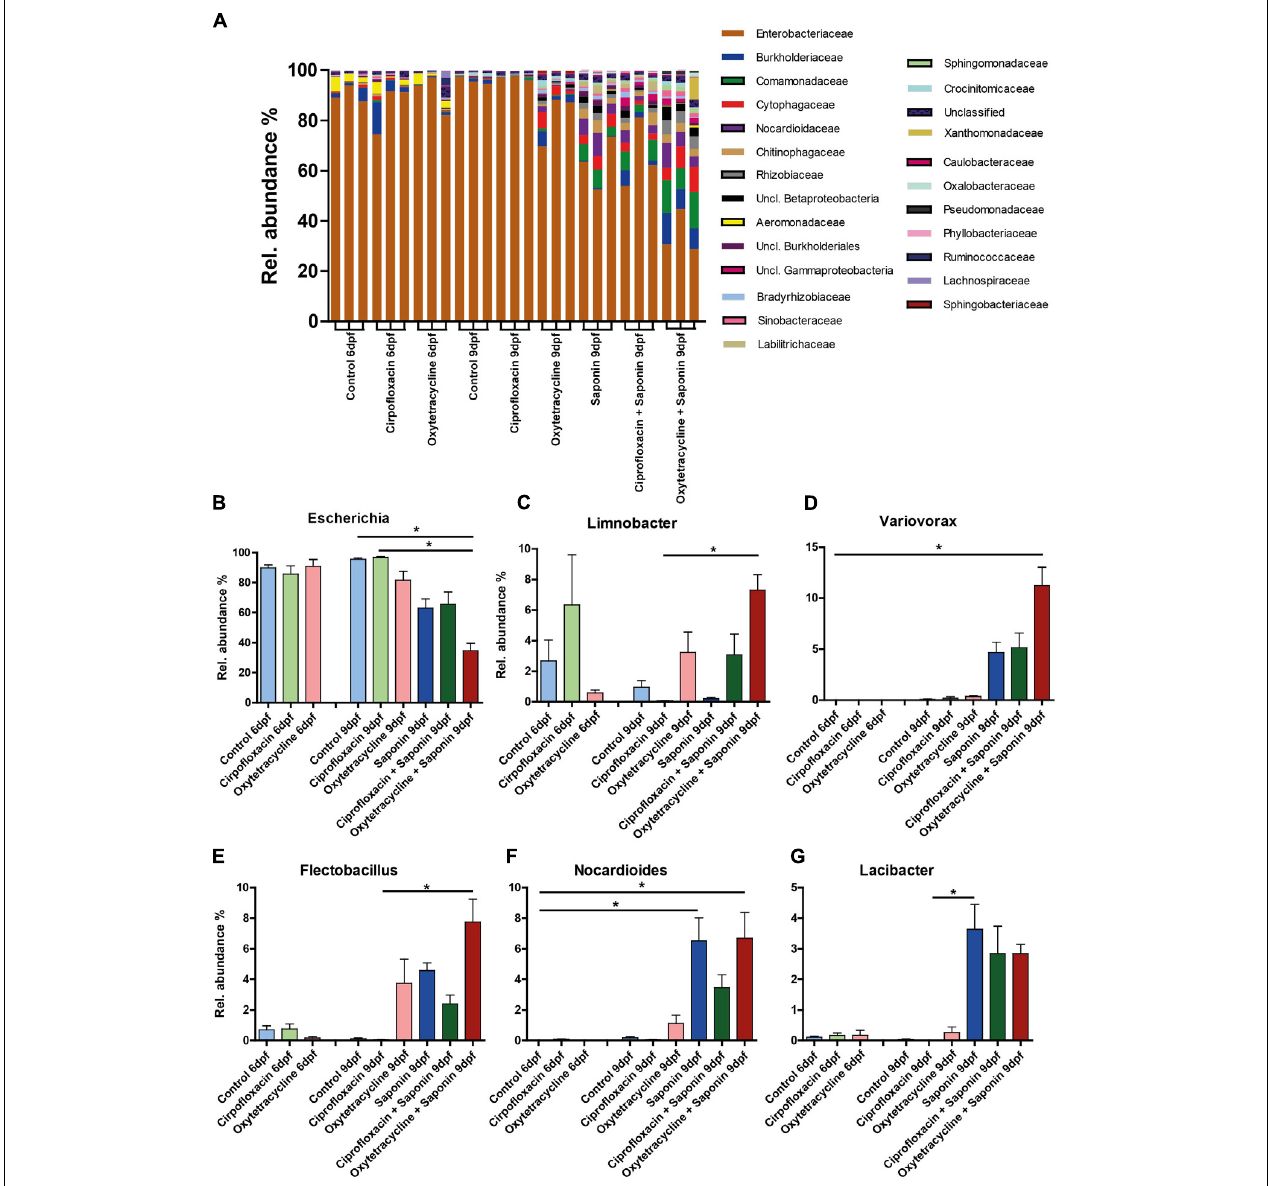
FIGURE 8 | Diversity of several bacterial genera increased at the expense of Escherichia after saponin and oxytetracycline exposure. (A) The overall average ≥ 0.05% abundant genera are displayed (3 pools of 5 larvae/treatment). The top 6 most abundant genera are displayed: (B) Escherichia, (C) Limnobacter (D) Variovorax (E) Flectobacillus (F) Nocardioides, (G) Lacibacter (mean ± SEM, ∗ p <